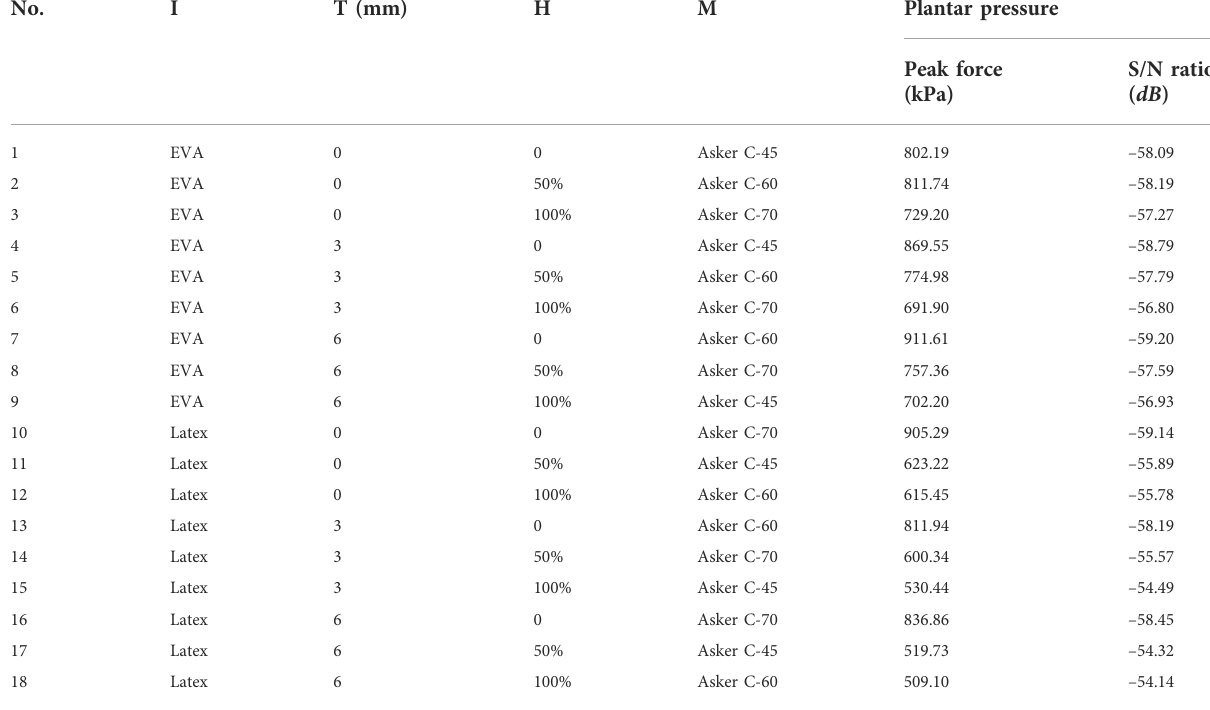
TABLE 3 Peak signal-to-noise ratio results of the plantar pressure at heel. No.